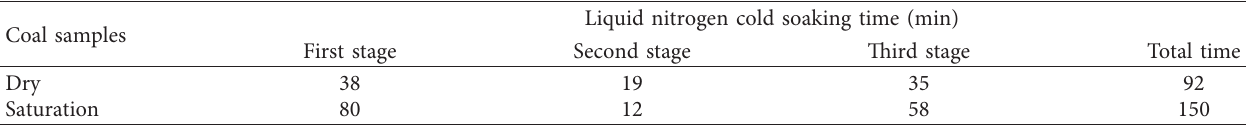
Figure 3: Change in the internal temperature of the coal samples. (a) Liquid nitrogen cold soaking process. (b) Room temperature recovery process. Table 1: Freezing time of coal samples at different temperature